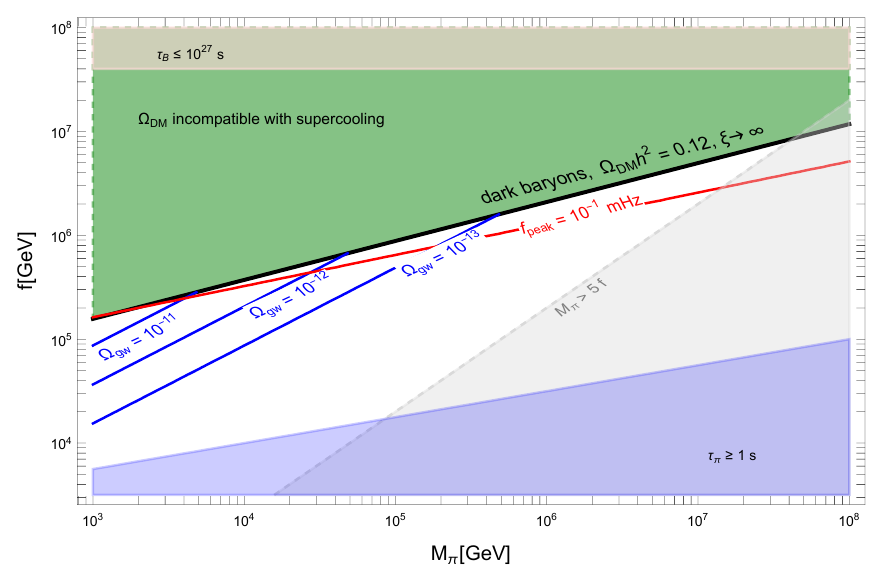
Figure 3. Gravity wave amplitude and frequency for the case of unstable pions. Blue and red isolines correspond to the amplitude and frequency of the gravitational waves respectively (assuming supercooling β/H ∼ O (1) ). In this region of parameter space the largest signal is achieved when the dark sector is initially at higher temperature than the visible one: the extreme scenario where DM abundance is reproduced starting from an empty visible sector ( ξ → ∞ ) is given by the solid black line. The points where blue and black lines intersect are predictions for the amplitude of the gravitational wave spectrum with the constraint on DM